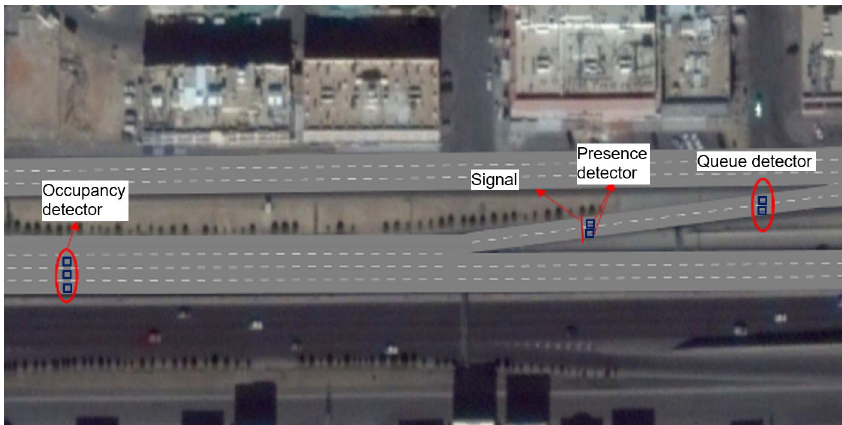
Figure 5. The layout of the tra ffi c responsive RM scenario.